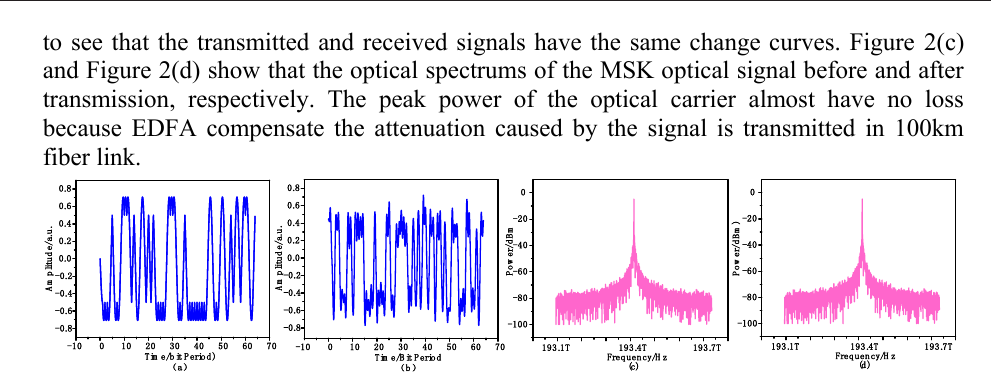
Fig.2. (a) The time domain waveform before transmission; (b) The time domain waveform after transmission; (c) The optical spectrum before transmission; (d) The optical spectrum after transmission.